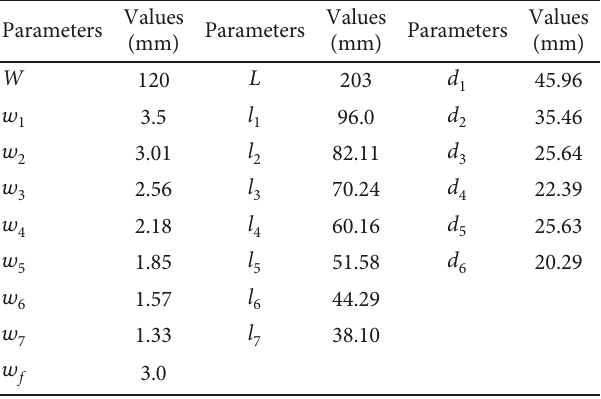
Table 1: Optimal parameters of log-periodic meandered dipole array (LPMDA) antenna.